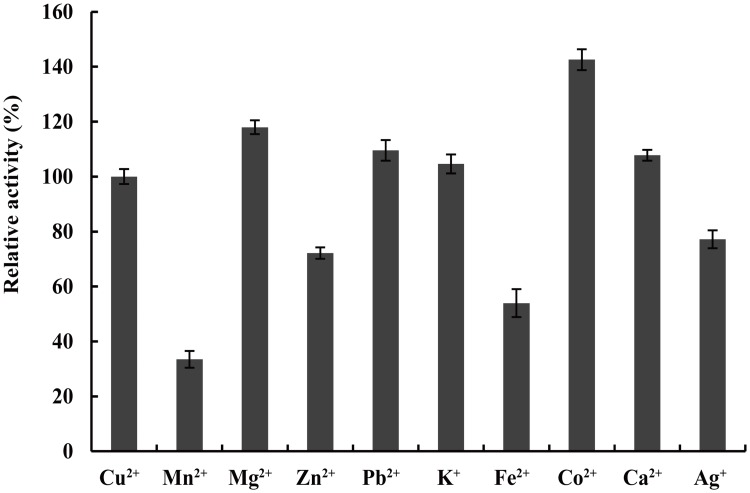
Effects of metal ions on LaclK activity.Enzyme activity was measured at 65°C in 50 mM Na2HPO4-KH2PO4 buffer (pH 7.0, supplemented with 0.2 mM CuSO4·5H2O) containing 1 mM metal ions and 2 mM 2,6-DMP.